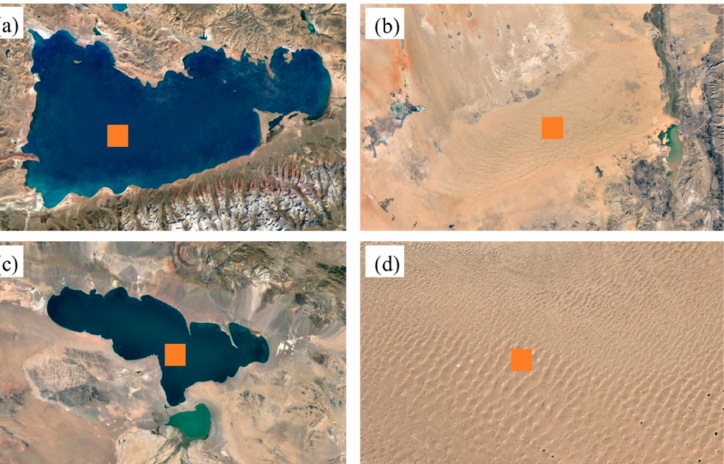
Figure 8. The selected sites for the validation of the FY − 3D MERSI-II thermal infrared channels’ in-situ radiometric calibration. ( a ) Lake Nam (30.718 N, 90.624 E) and ( b ) the Gobi Desert (39.647 N, 106.257 E) near Wuhai city were chosen for 18 August and ( c ) Lake Kyrgyz (49.168N, 93.277 E) and ( d ) the Badain Jaran Desert (40.201 N, 101.411 E) were chosen for 20 August. Each selected region (red boxes) denotes the selected area used for